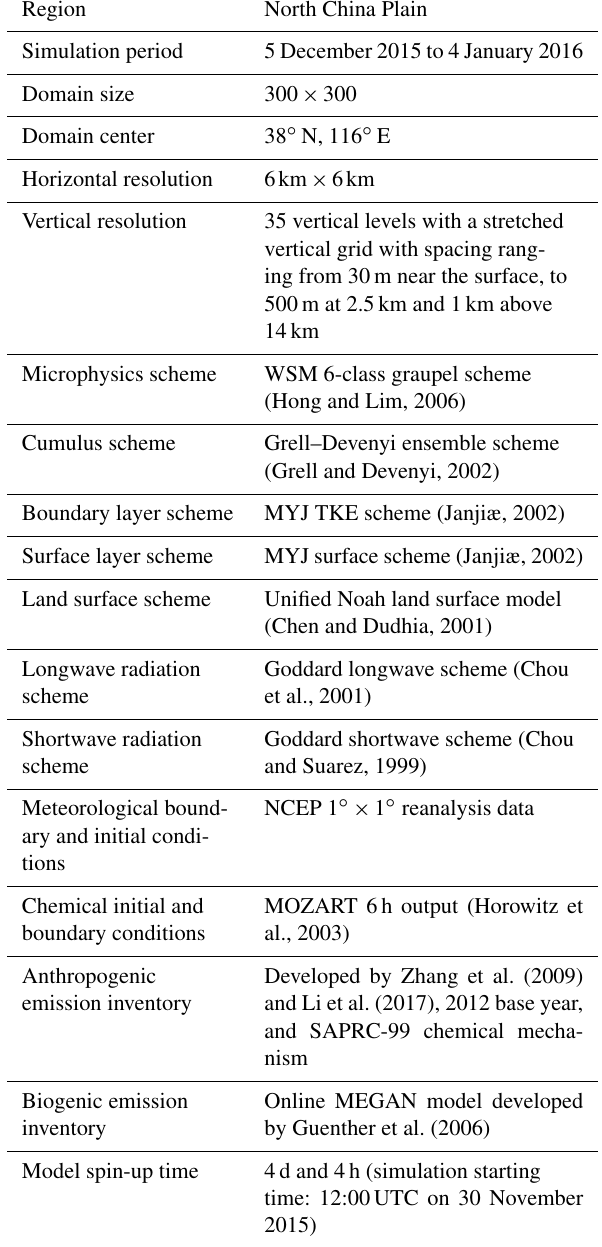
Table 1. WRF-Chem model configurations. Region